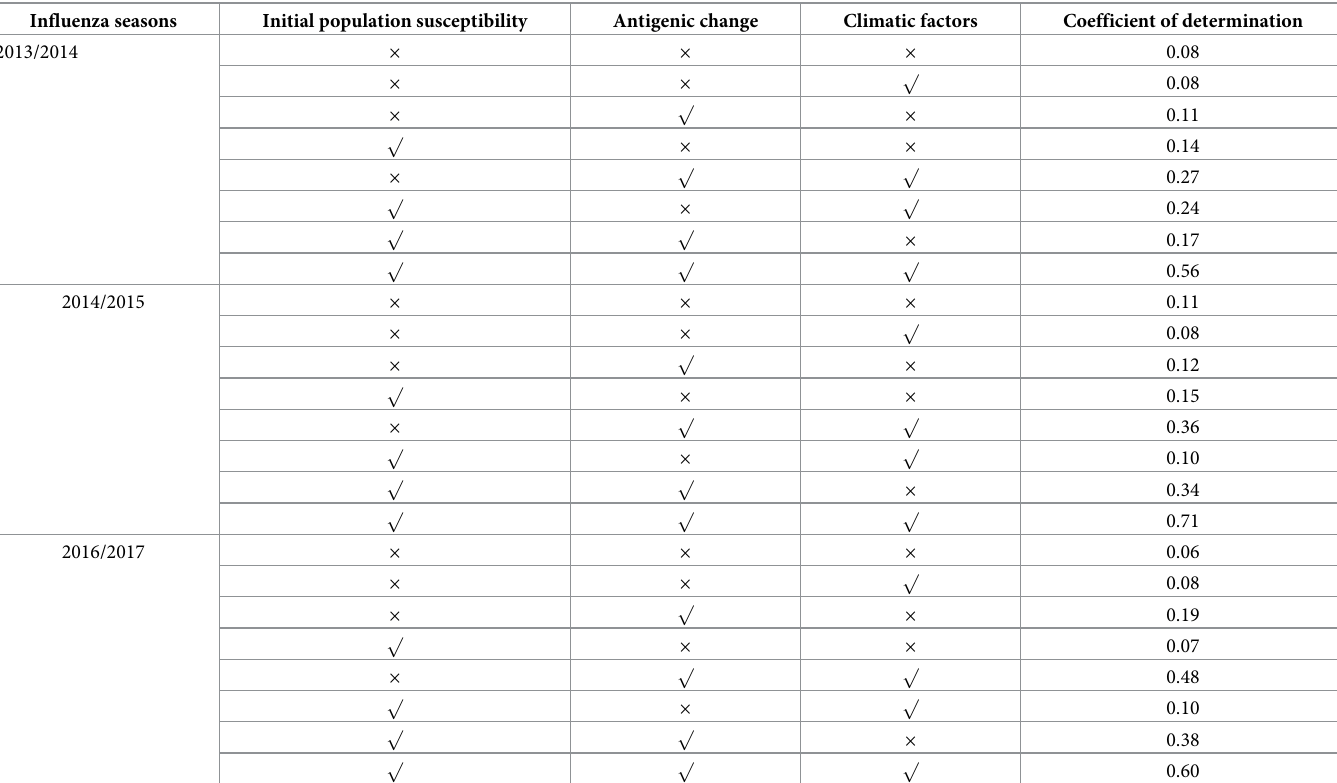
Table 2. Variations explained by the major driving factors on the dynamics of influenza